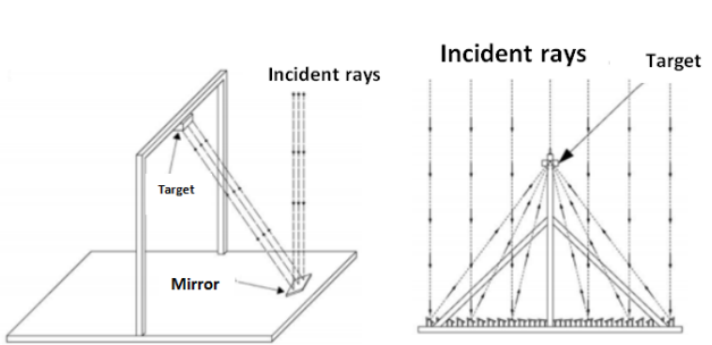
Figure 16. Planar concentrator, based on non-imaging mirrors [23]. Reprinted from K.K. Chong et